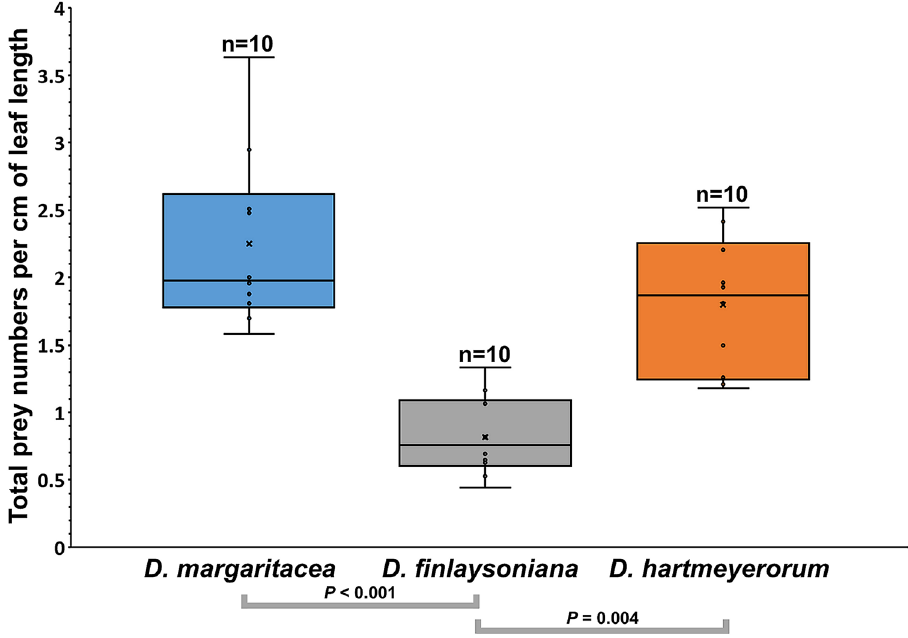
Figure 4. Total prey numbers per cm of leaf length in three species of Drosera sect. Arachnopus in Western Australia. Grey brackets indicate significant differences between